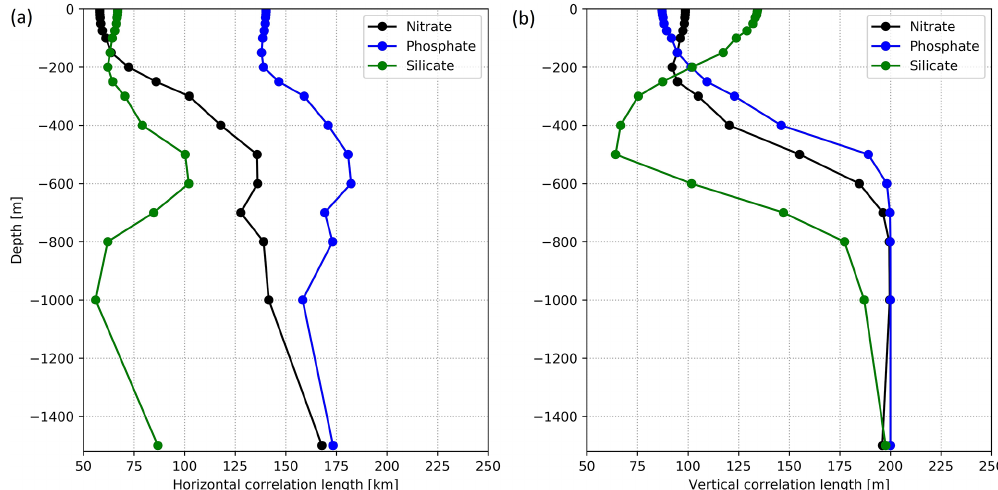
Figure 6. (a) Horizontal and (b) vertical optimized correlation lengths, for each nutrient (1981–2017), as a function of depth.